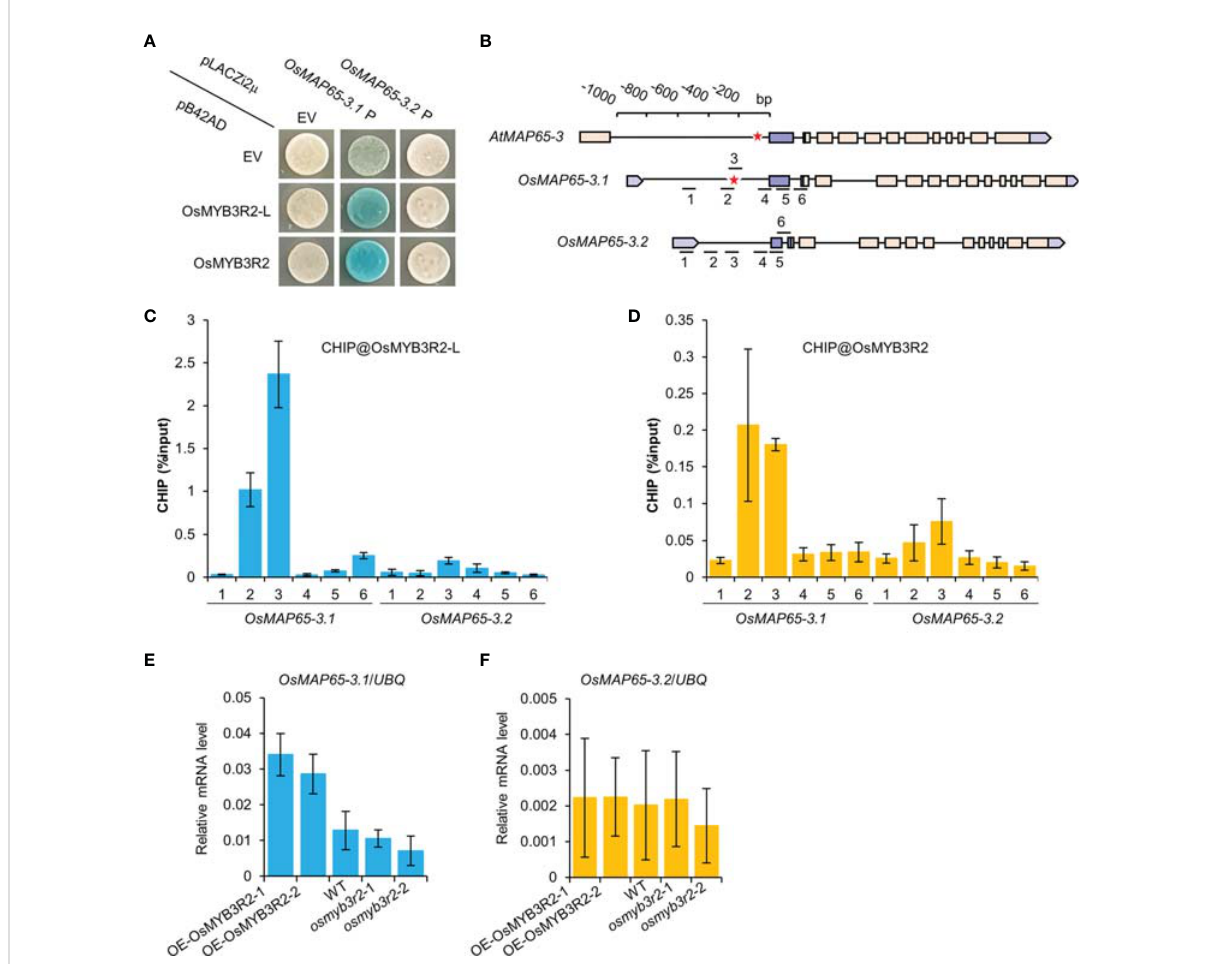
FIGURE 7 The interactions of OsMYB3R2 transcription factors with the OsMAP65-3 genes promoters. (A) Yeast-one-hybrid assay showing that OsMYB3R2 and OsMYB3R2-L can bind to the OsMAP65-3.1 promoter but not OsMAP65-3.2 promoter. (B) The position of MSA element and the primers used for ChIP in the promoters of AtMAP65-3 , OsMAP65-3.1 and OsMAP65-3.2 . The red asterisk represents the position of the MSA element. (C, D) ChIP-qPCR results showing that OsMYB3R2-L (C) and OsMYB3R2 (D) bind to OsMAP65-3.1 promoter rather than OsMAP65-3.2 promoter, and OsMYB3R2-L and OsMYB3R2 were enriched at the region covered by ChIP-qPCR primer 2 and 3. Data are shown as means ± SD (n = 3). (E, F) The transcription level of OsMAP65-3.1 (E) and OsMAP65-3.2 (F) in OsMYB3R2 overexpression and knockout